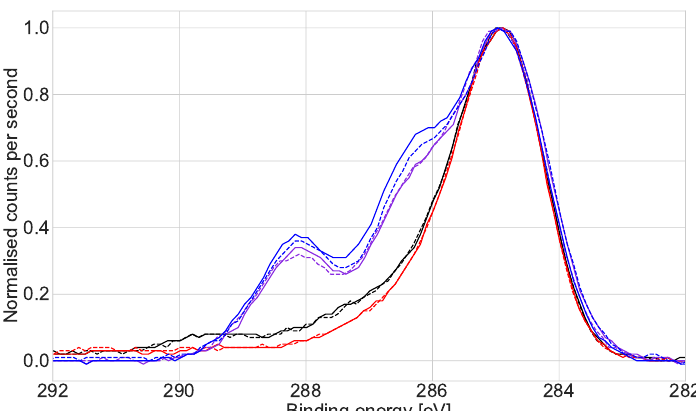
Figure 8. Normalised C 1s XPS spectra of the working electrode after 7 days of incubation in standard culture conditions (37 ◦ C, 5% CO 2 ). Black lines show the bare gold electrode exposed to air. Red lines show the electrode exposed to DPBS, purple lines show exposure to DMEM + FBS and blue lines show collagen gel in DMEM + FBS, these electrodes were cleaned with L-cysteine prior to exposure to the aqueous